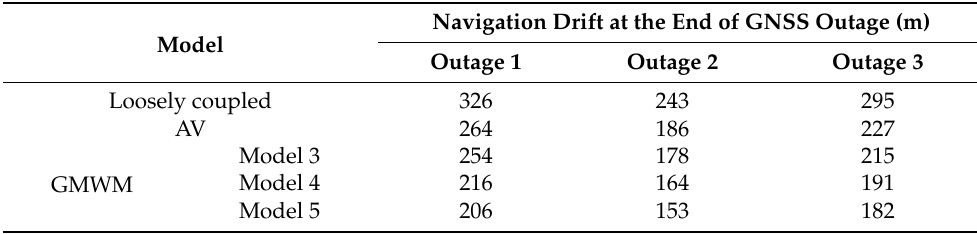
Figure 6. The navigation drift of the five models at the end of three GNSS outages. Table 1. The maximum navigation error of the five models at the end of three GNSS outages. Model